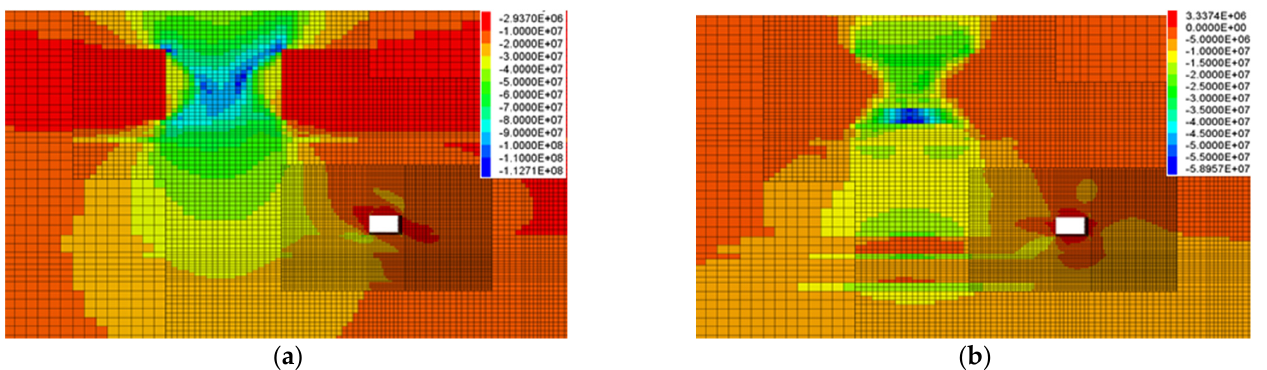
Figure 11. Plastic zone distribution cloud map when the roadway excavation leaves top coal bottom coal.